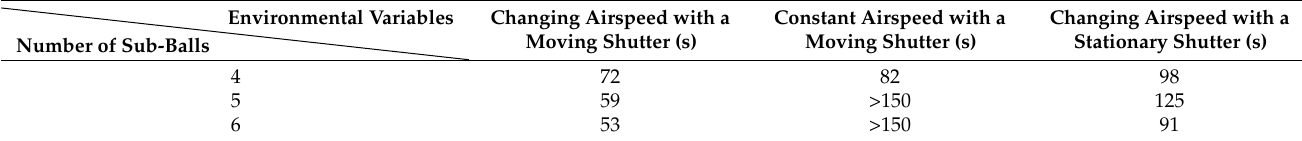
Table 1. The specific assembly time for the three groups of